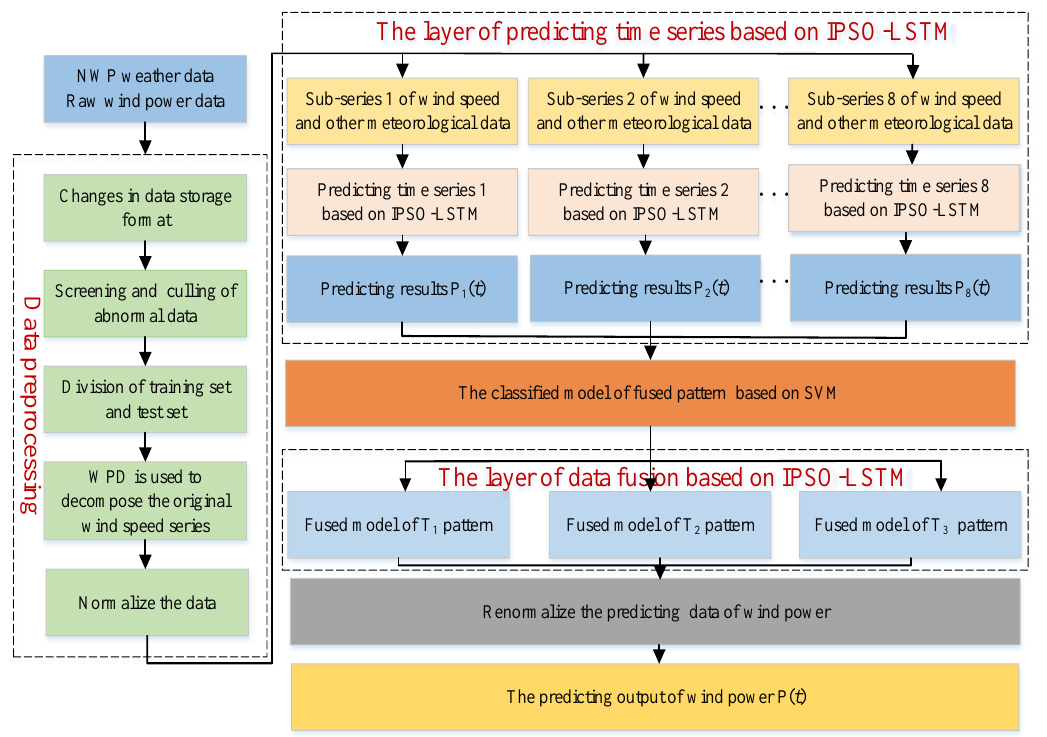
Figure 1. Overall framework of the forecasting model of wind power.